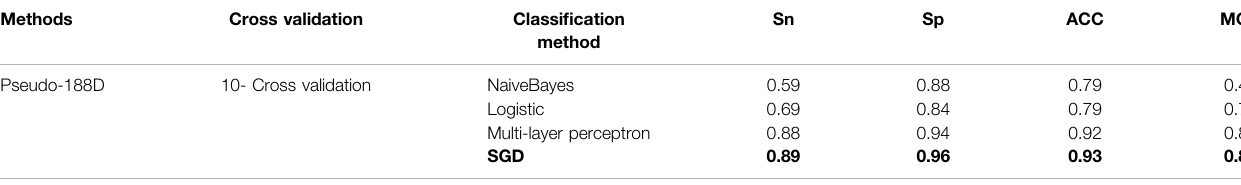
TABLE 2 | Performance comparison of the same method in different classi fi ers.